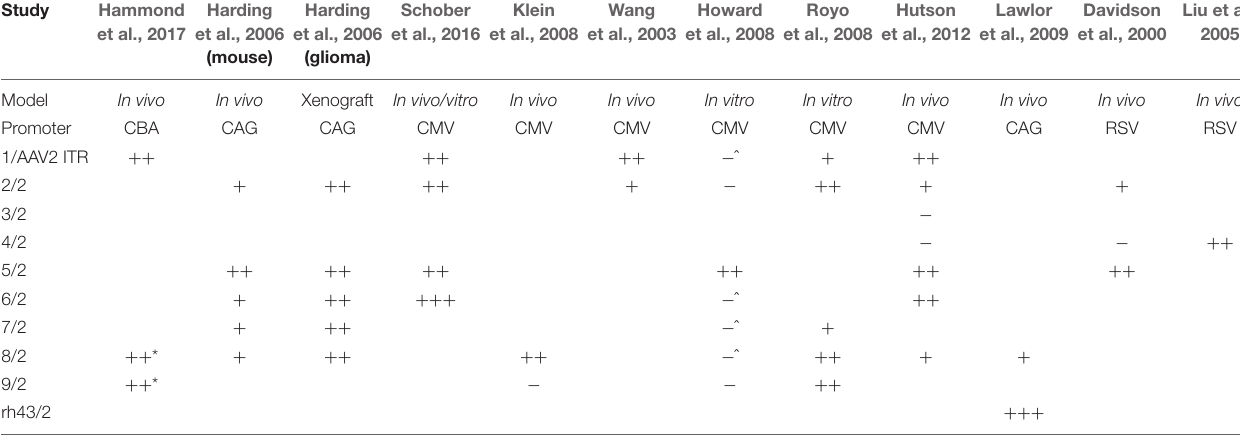
TABLE 1 | Astrocyte transduction of AAV serotypes with pan-cellular